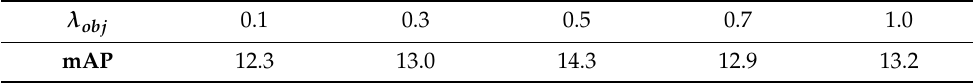
Figure 3. Some examples of visualizing the impact of the objectness branch. In each comparative example, the top picture shows the ground truth, the middle picture shows the results without objectness branch, the bottom picture shows the results with the objectness branch. Table 5. Experiment to determine the weight of objectness